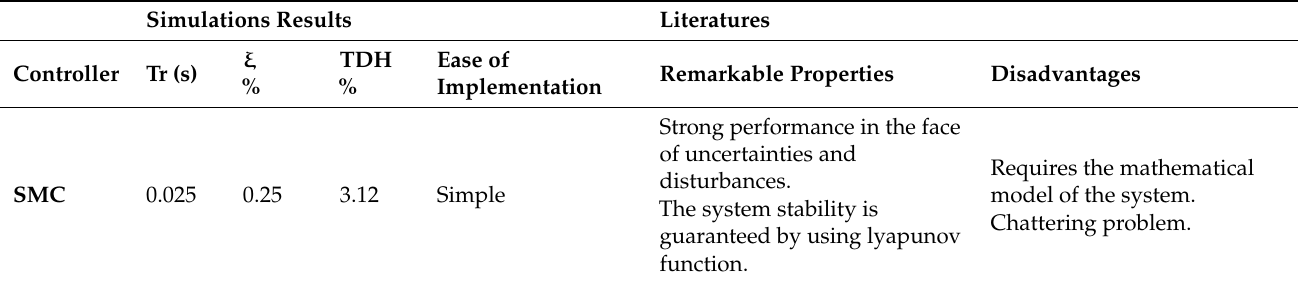
Table 9. Comparison of the four reviewed